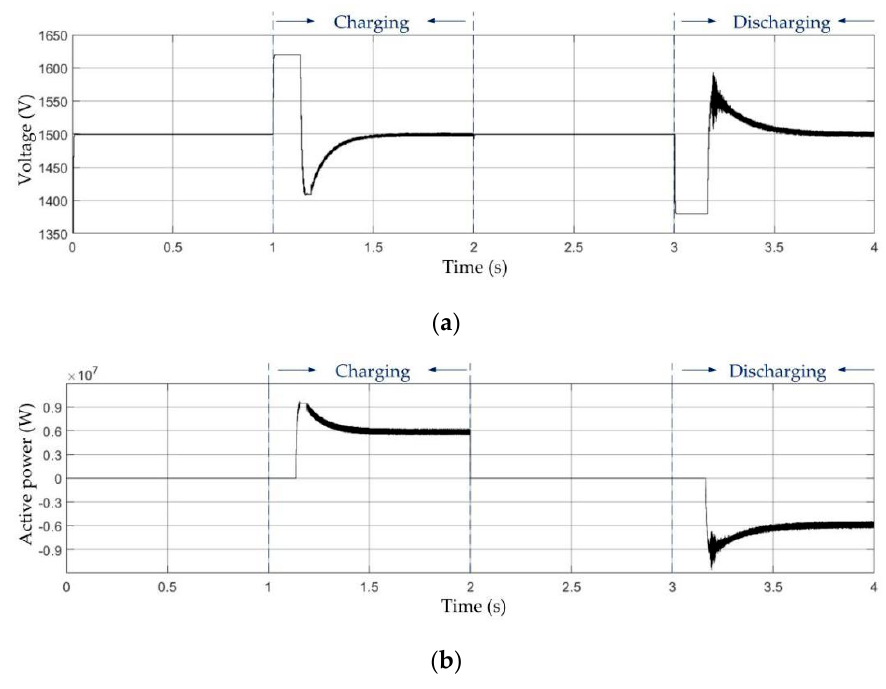
Figure 17. Dynamic response of the energy storage module to variation of the DC bus voltage: ( a ) the DC bus voltage; and ( b ) the active power of the module.